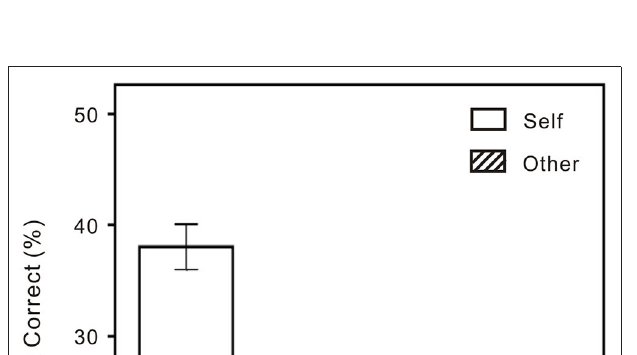
FIGURE 2 | the encoding phase in CIR, AGSs from two of the lists (i.e., 24 AGSs) were presented with one list in blue and the other in red randomly. In the retrieval phase in CIE and the retrieval phase in CIR, AGSs from all three lists (i.e., two lists presented in the encoding phase and one list previously unseen) were randomly presented in black. In the encoding phase in CIE and the retrieval phase in CIR, half of the participants were reminded that they were to use blue AGSs, and the other half of the participants were reminded that they were to use red AGSs. For example, “Mike uses blue AGSs and Joe uses red AGSs” or “Mike uses red AGSs and Joe